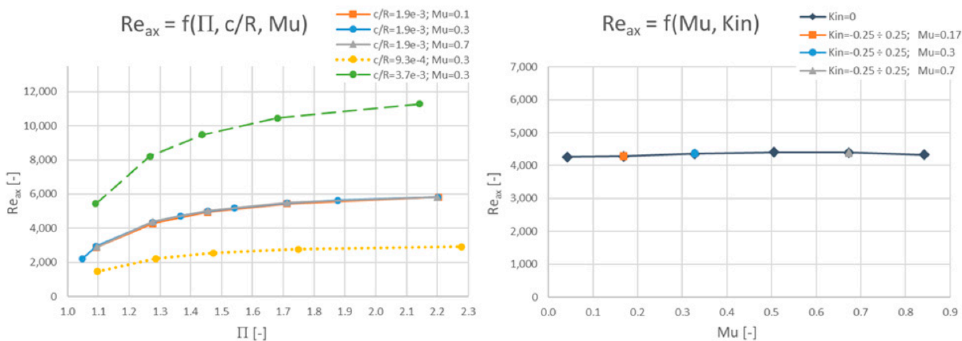
Figure 3. Dependency of axial Reynolds number on Π , c / R , M u , and K in